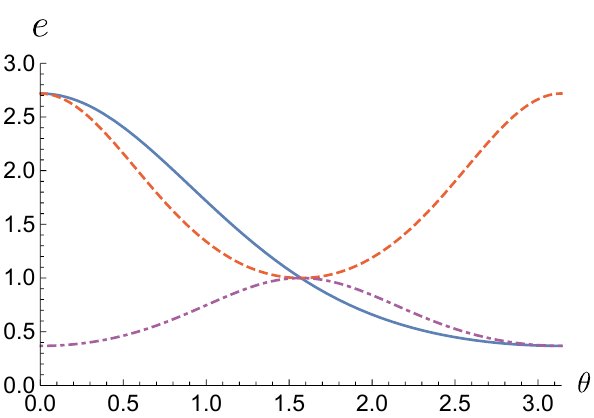
Figure 4 . Snap shots of solutions (3.11) that lump near poles and form a belt around the equator. The single-spot solution (solid) corresponds to ‘ = 1 and a 1+ > 0 (with all other a ‘ (cid:6) = 0). The double-spot solution and belt solution (dashed and dot-dashed) correspond to ‘ = 2 and a 2+ = 1 or (cid:0) 1 (with all other a ‘ (cid:6) =